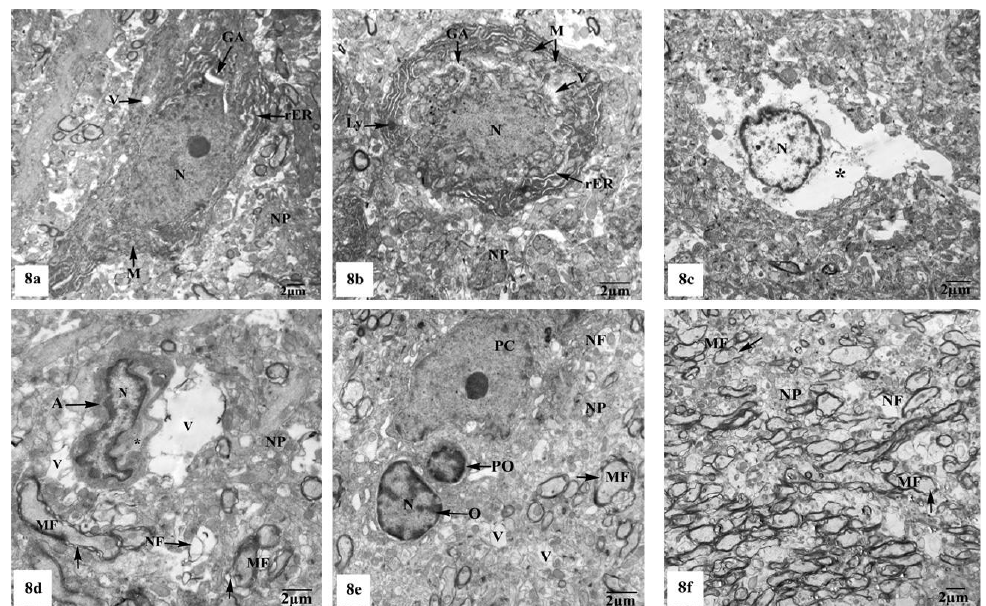
containing normal myelinated (MF) and non-myelinated (NF) fibers is observed; ( c , g ) oligodendrocytes (O) having electron-dense ovoid nuclei (N) and cytoplasm with rER and Golgi apparatus (GA), in addition to cytoplasmic extensions (C) are seen. The surrounding neuropil (NP) comprising some myelinated (MF) and non-myelinated (NF) axons is also observed; ( d , h ) numerous myelinated (MF) nerve fibers with regular myelin sheaths ( ← ) or non-myelinated (NF) nerve fibers are seen in the neuropil (NP).